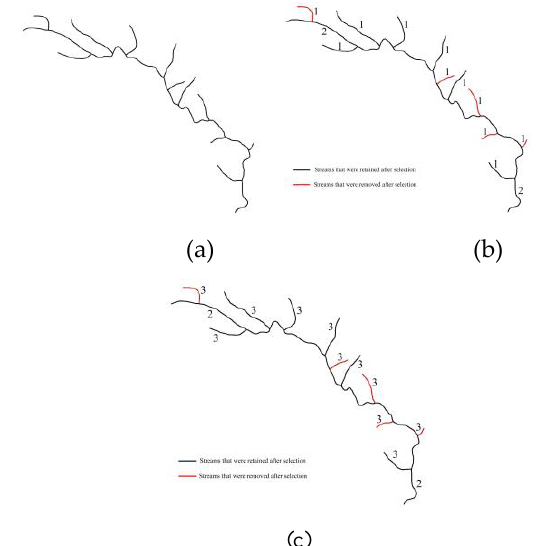
Figure 7. Comparison of selections in an ordinary river substream: (a) original map, (b) selections based on Horton’s coding system and (c) selections based on our coding system